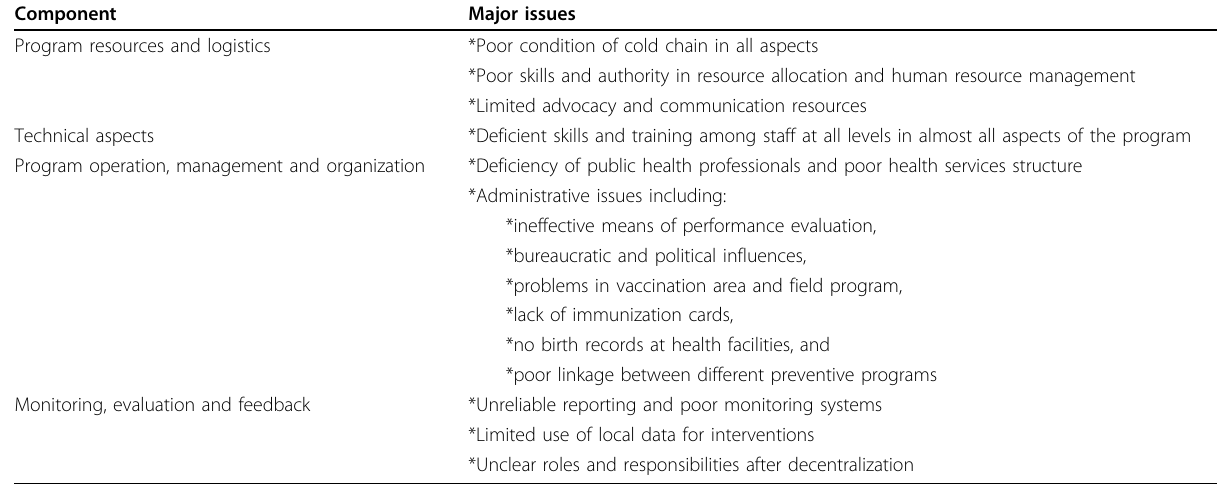
Table 1 Perceptions of health workers and managers regarding constraints in the Polio Eradication Initiative